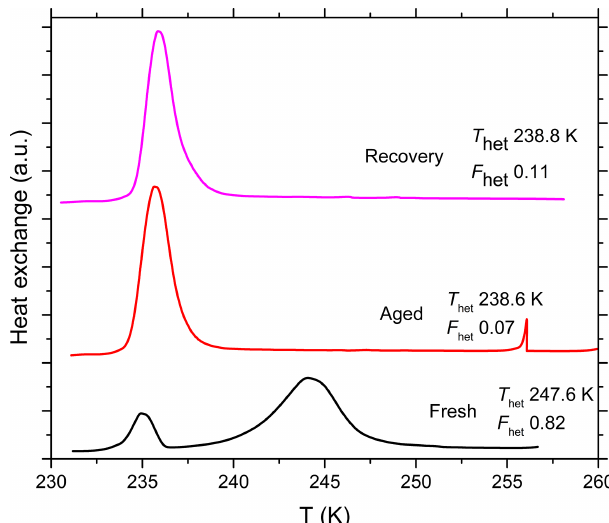
Figure 7. DSC thermograms of SA quartz (5wt%) suspended in pure water in borosilicate glass vials and measured right after prepa- ration (marked as “Fresh”). The same suspension was aged for 7 months and remeasured (marked as “Aged”). The aged suspen- sion was centrifuged, the supernatant decanted, the aged particles washed several times with pure water, resuspended in pure water and measured again to examine the recovery of IN efficiency after aging (marked as “Recovery”). This procedure was done with three different suspensions and their mean T het and F het are reported next to each curve. All curves are normalized such that the areas under the heterogeneous and homogeneous freezing curves sum up to the same